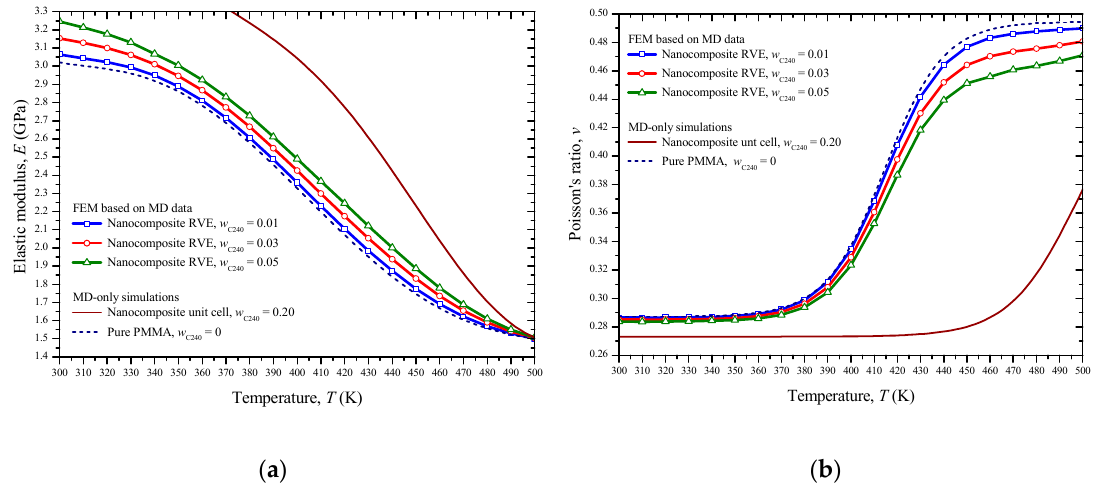
Figure 12. The ( a ) elastic modulus and ( b ) Poisson ratio of the nanocomposite with small fullerene mass fractions with respect to the temperature, predicted by combining FEM and MD.